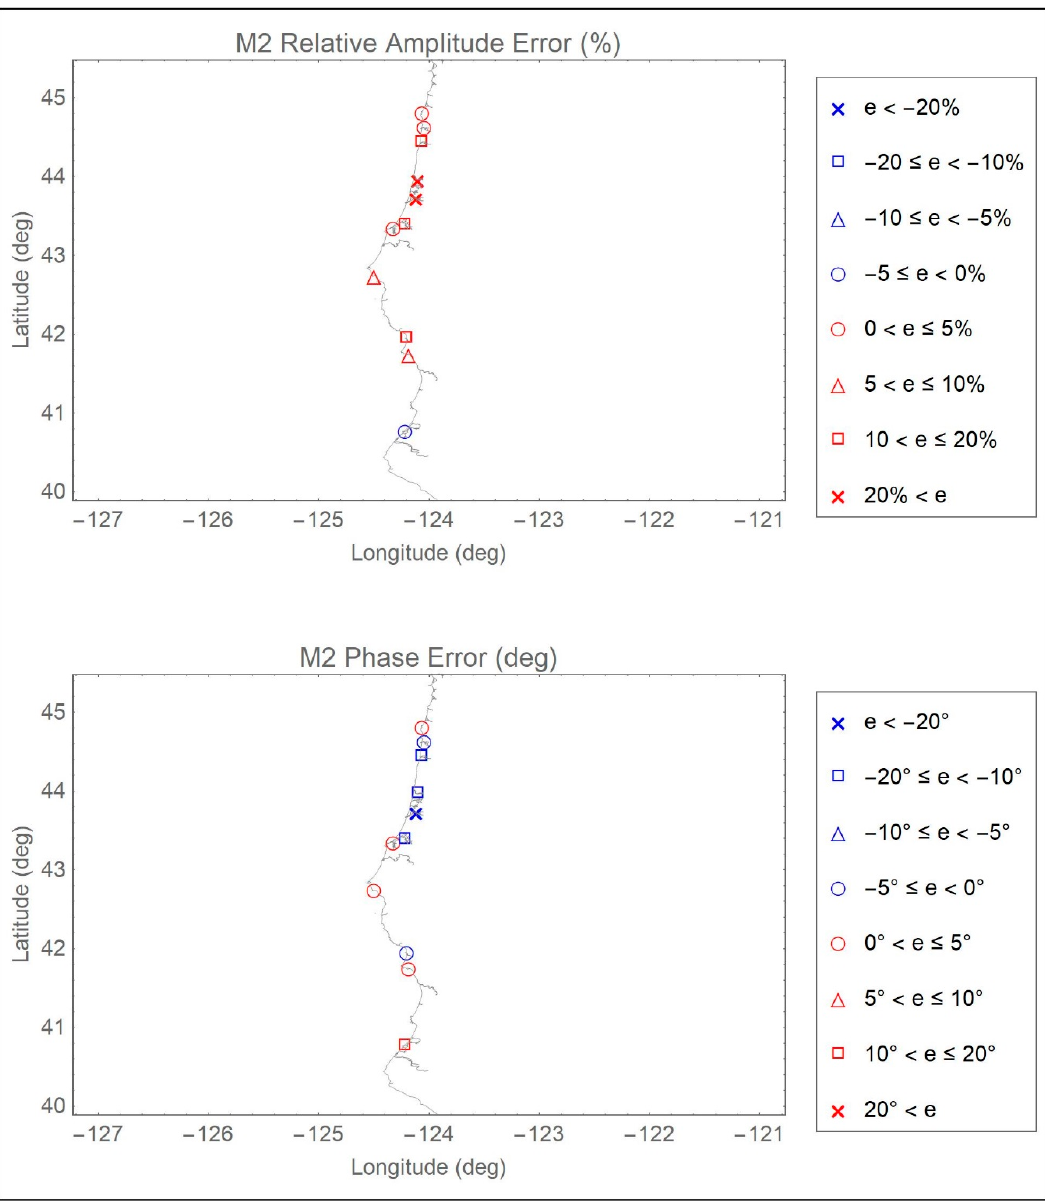
Figure A17. Distribution of ENPAC15 relative amplitude (%) and absolute phase (deg) errors for the M 2 constituent: Northern California coast view.